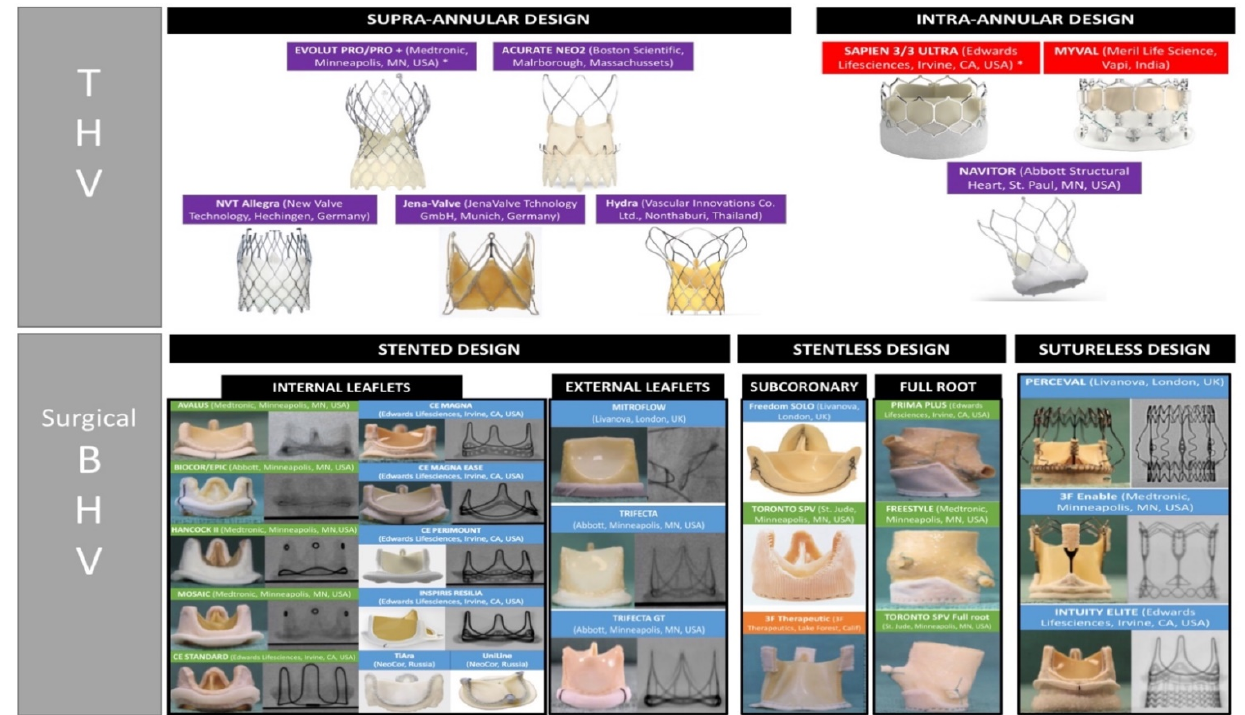
Figure 1. Available portfolio of THVs and surgical BHVs regrouped according to their main features: in purple, devices with self-expanding design; in red, devices with balloon-expandable design; in green, devices made by porcine tissue; in blue, devices made by bovine pericardial tissue; in orange, devices made by equine pericardial tissue. BHV: bioprosthetic heart valve; THV: trans-catheter heart valve. *CE mark for valve-in-valve use. Table 2. Feasibility of BVF/BVR in surgical BHVs.